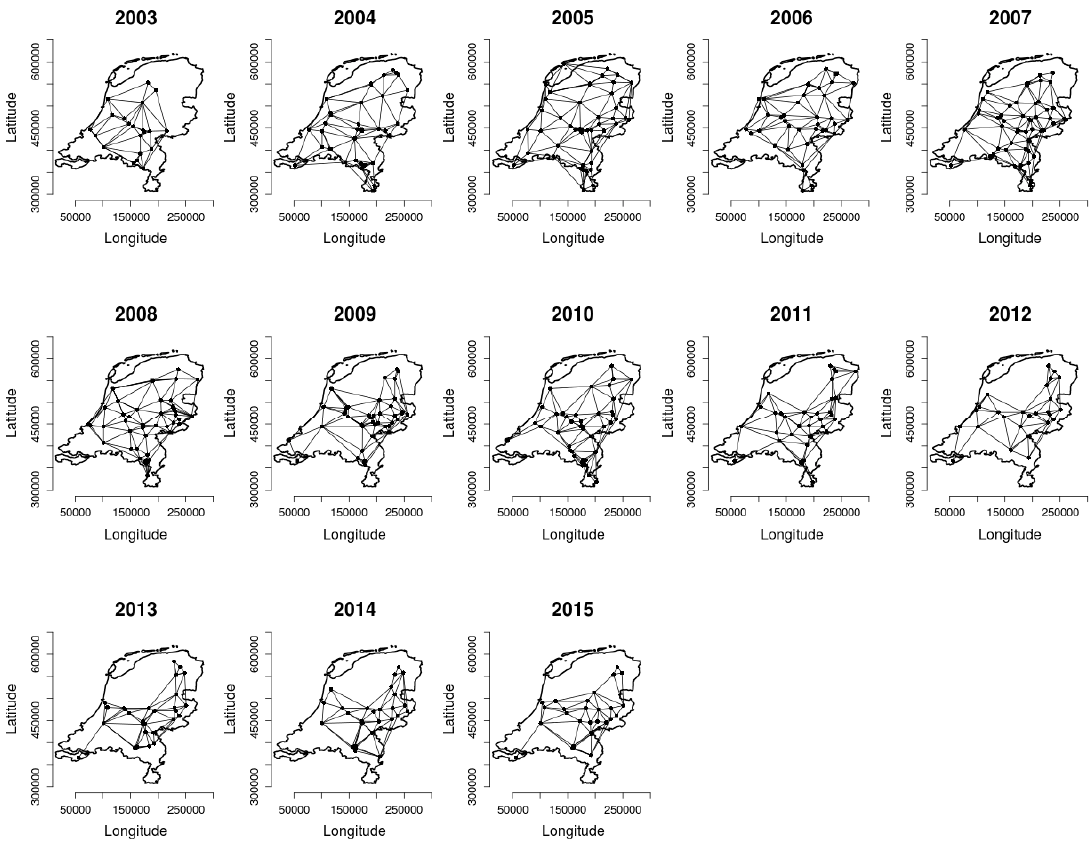
Figure A3. Annual graphs for pedunculate oak flowering onset observations. The graphs were made using a Delaunay triangulation and edges longer than 100 km were pruned.